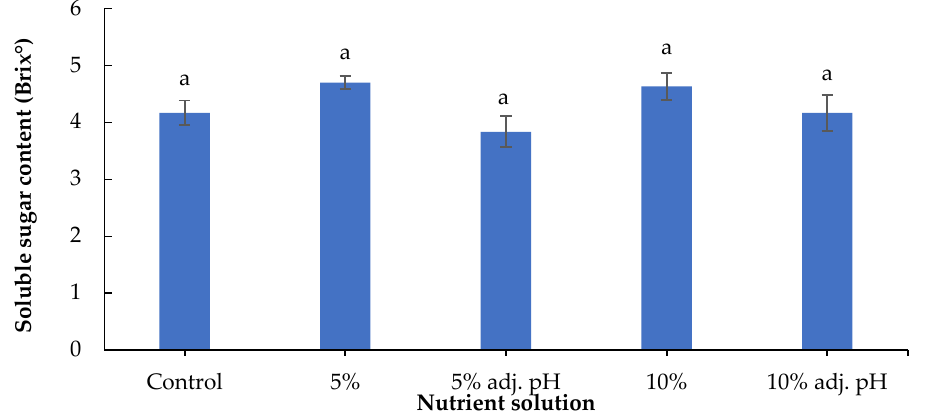
Figure 8. Soluble sugar content (Brix ◦ ) of baby lettuce leaves grown in a floating hydroponic system under different dilutions in water during the winter period. Columns (means ± SE) with different letters are significantly different ( p < 0.05).